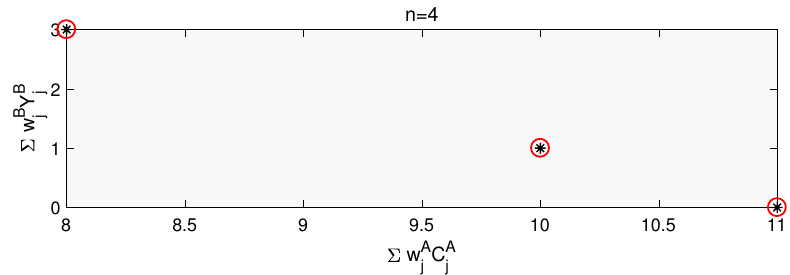
Figure 1. The black stars are the points generated by Algorithms 1 and 2, the red circles are points generated by Algorithm